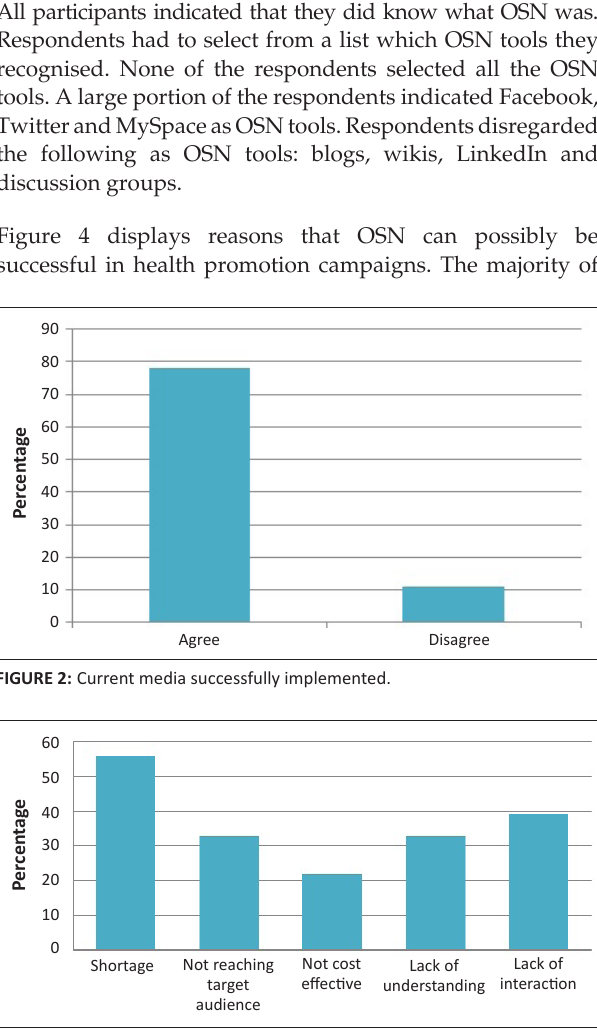
FIGURE 3: Reasons for current media being unsuccessful.